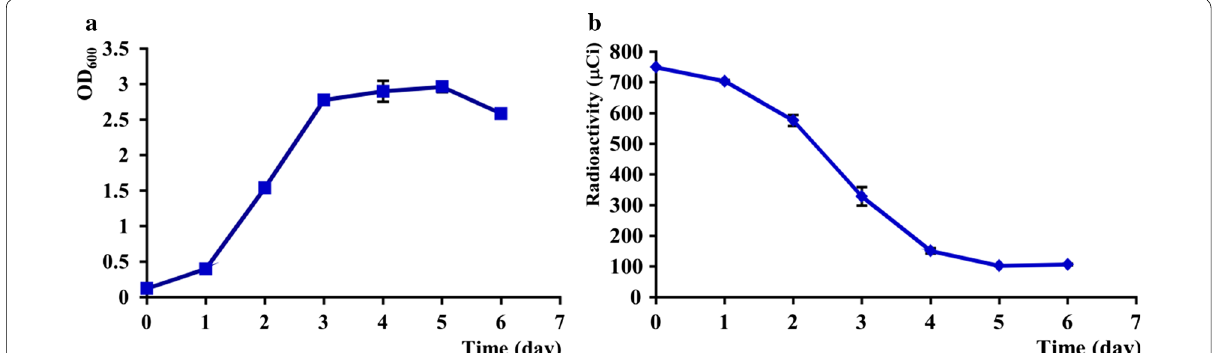
Fig. 3 The growth rate and U- 14 C-DHA production in C. cohnii . a OD 600 ; b glucose consumption. 300 μL/batch